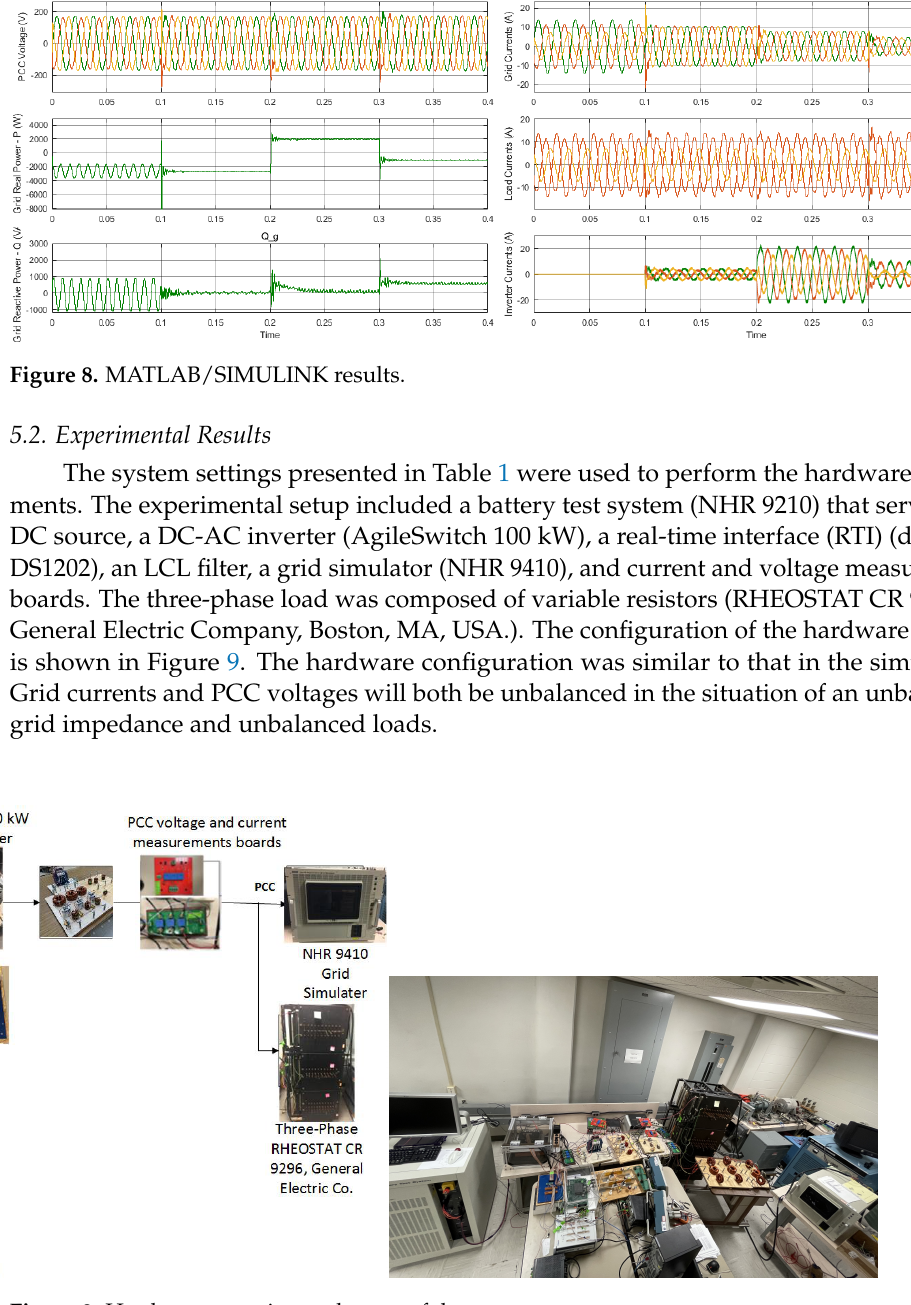
Figure 9. Hardware experimental setup of the